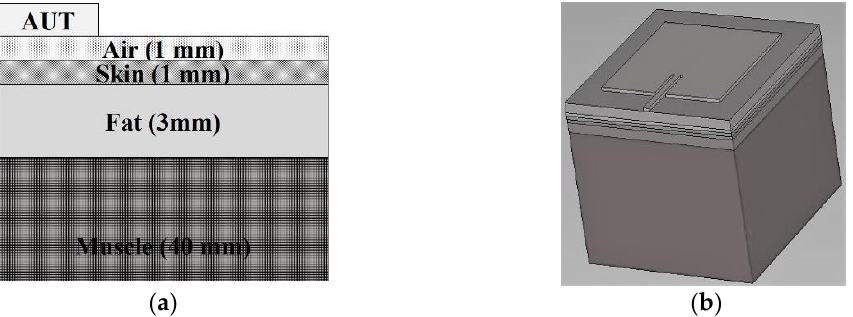
Figure 4. ( a ) 2D Body phantom model of four layers and ( b ) 3D body phantom model of four layers. Table 2. Dielectric properties of human tissues at 2.45 GHz [45].